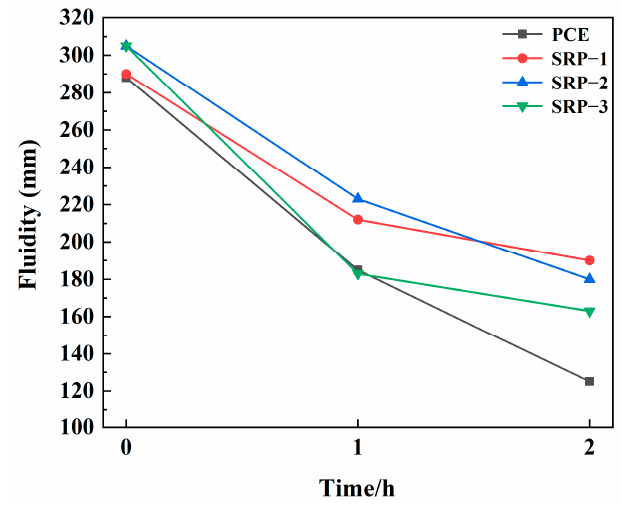
Figure 2. Fluidities and fluidity retentions of cement pastes containing PCE or SRP.